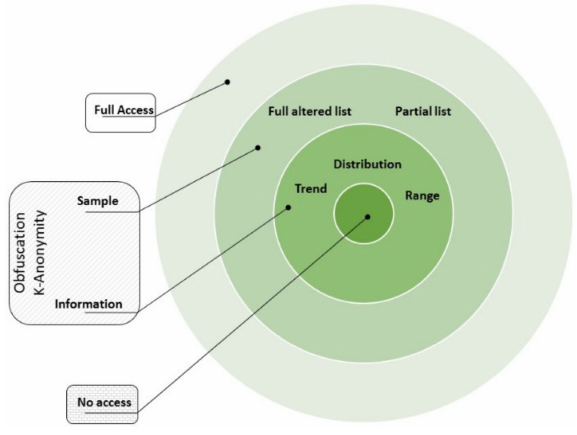
Figure 7. Access